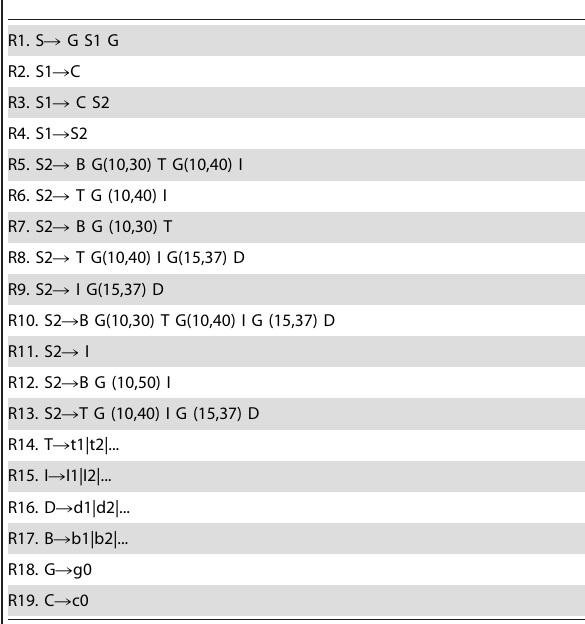
Table 3. Production rules of grammar G1 generation the promoter region of a human DNA